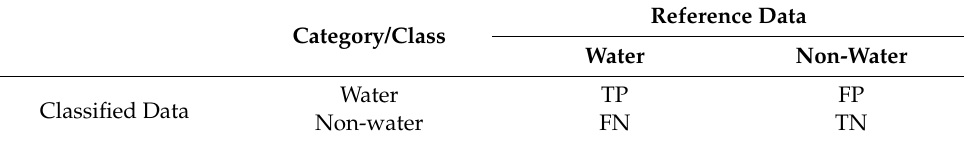
Table 3. The confusion matrix. Reference Data Category/Class Water Non-Water Water TP FP Classified Data Non-water FN